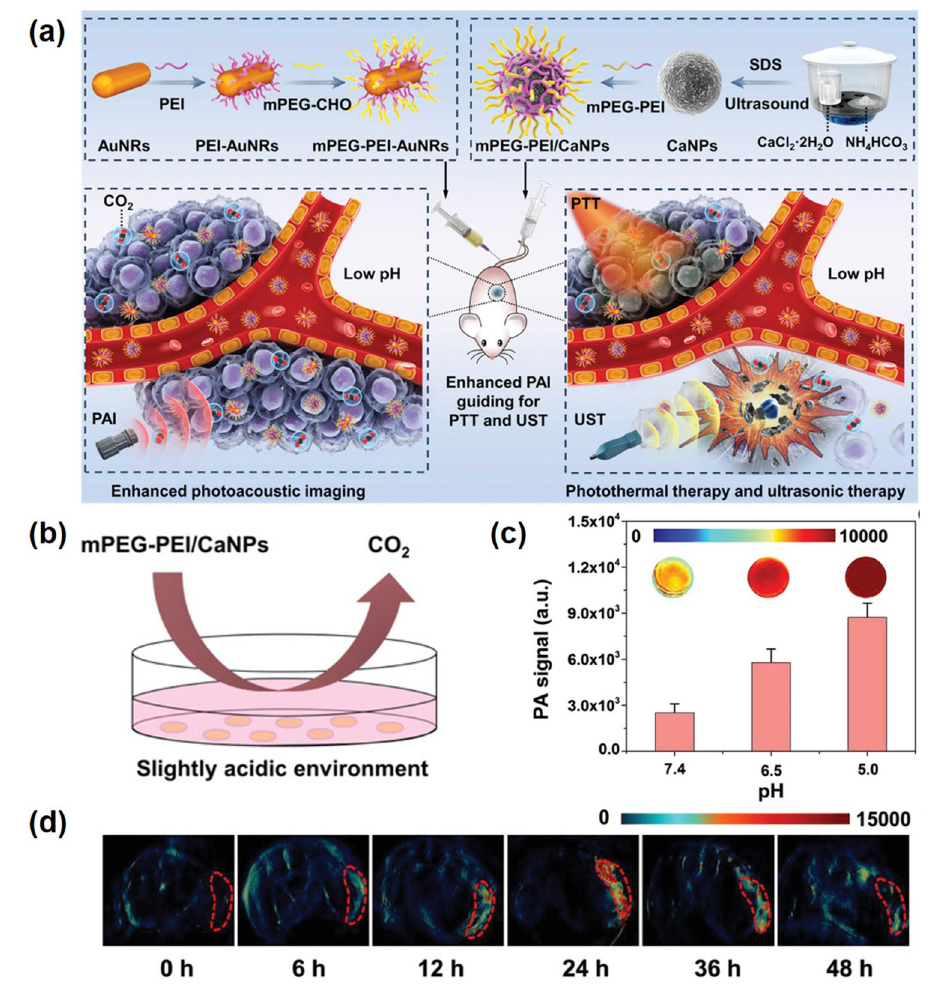
Fig. 3 Calcium carbonate-enhanced ultrasonic imaging. a Schematic diagram of synthesized mPEG–PEI–AuNRs and mPEG–PEI/CaNPs with enhanced PA imaging for the synergistic of photothermal therapy and ultrasonic therapy. b Schematic diagram of CO 2 bubbles produced by mPEG-PEI/CaNPs in a simulated acidic TME. c PA signals of mPEG-PEI-AuNRs and mPEG-PEI/CaNPs under different pH values. d PA sig- nals of mPEG-PEI-AuNRs and mPEG-PEI/CaNPs in tumor tissues [50]. Copyright 2021,